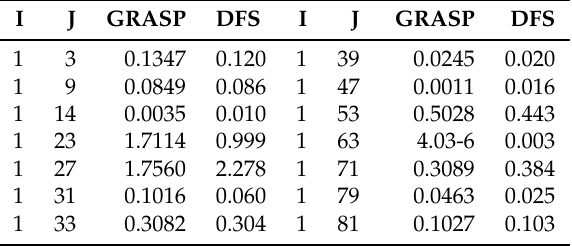
Table 12. Comparison of oscillator strengths ( f -values) for some transitions of Y